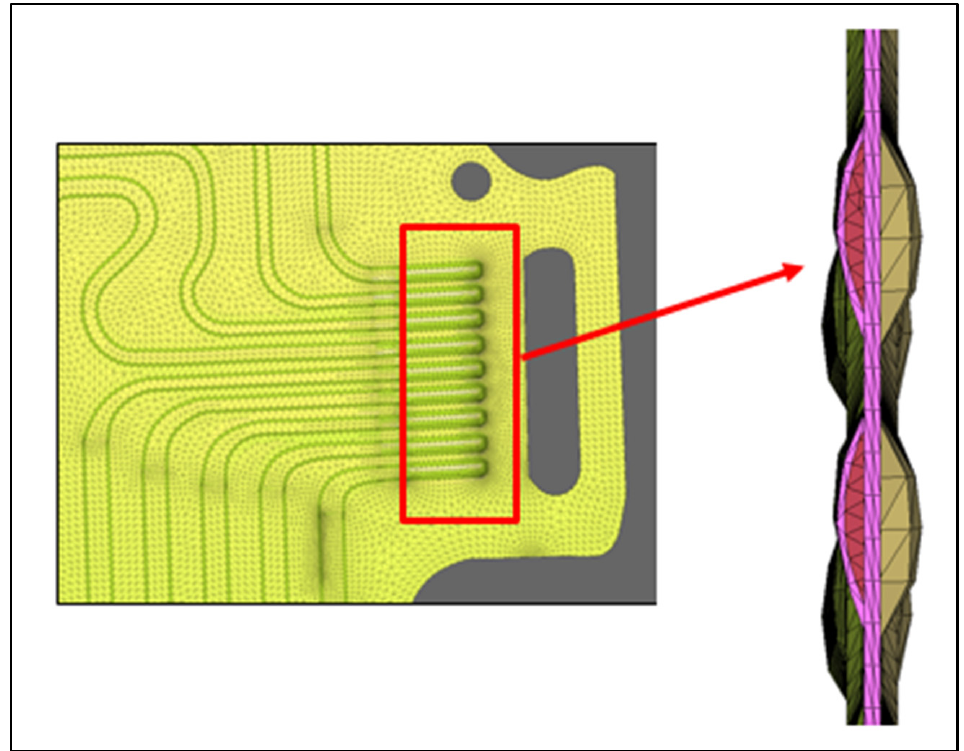
Figure 6. Meshing in inlet channels in DEP MeshWorks 8.0.